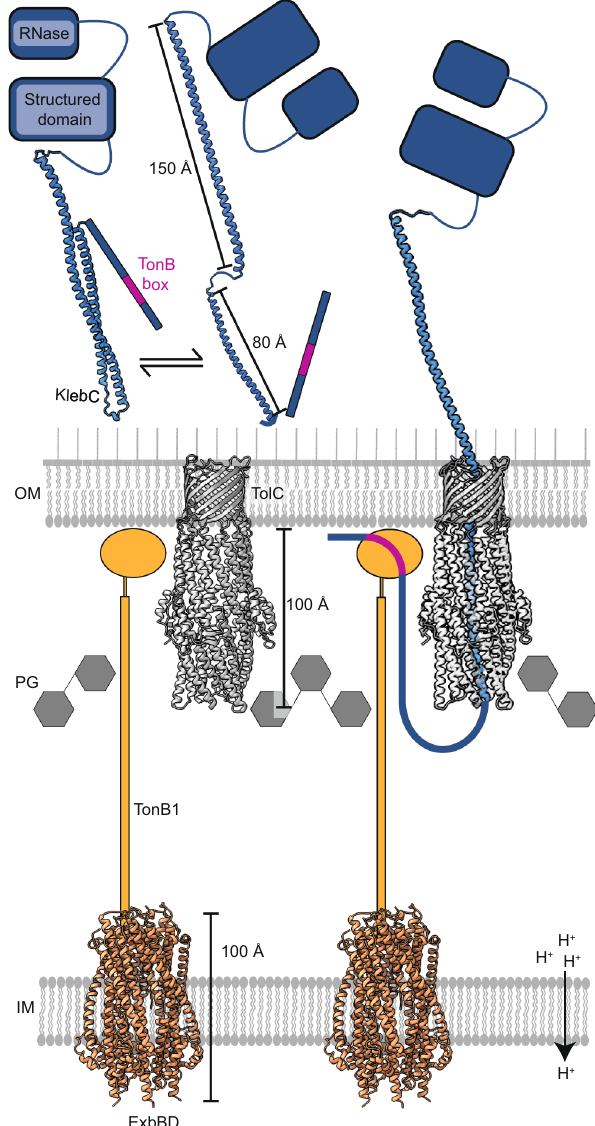
Fig. 5 Model depicting how the KlebC toxin crosses the OM through TolC. The N-terminal domain of KlebC (blue) exists as a folded hairpin in solution, with a disordered N-terminal domain containing a TonB-box sequence (magenta). The helical hairpin is likely in equilibrium with an unfurled counterpart, which is the binding-competent form of KlebC. We speculate that electrostatic attraction brings the positively charged N- terminus of KlebC into the negatively charged TolC channel. Thereafter, KlebC snakes through the TolC channel, resulting in ultra-slow association kinetics for the complex. The disordered N-terminal region of KlebC then passes through the periplasmic entrance of TolC, which likely requires fl exing of the iris helices to accommodate a disordered polypeptide. Around 70 residues at the N-terminus of KlebC escape the iris leaving the helical regions of KlebC docked within the TolC channel. The disordered nature of these residues means that a wide search radius is possible. Toxin translocation is driven by TonB, which associates with the KlebC TonB box (residues 16 – 20), in conjunction with the PMF-linked inner membrane stator complex ExbB-ExbD. Previous work on TonB-dependent bacteriocins has shown that this protein – protein interaction is suf fi cient to drive entry into the cell 13 . How the nuclease then translocates to the cytoplasm is not known but may involve the inner membrane AAA + ATPase/protease FtsH, as has been shown for E. coli -speci fi c colicins 52, 53